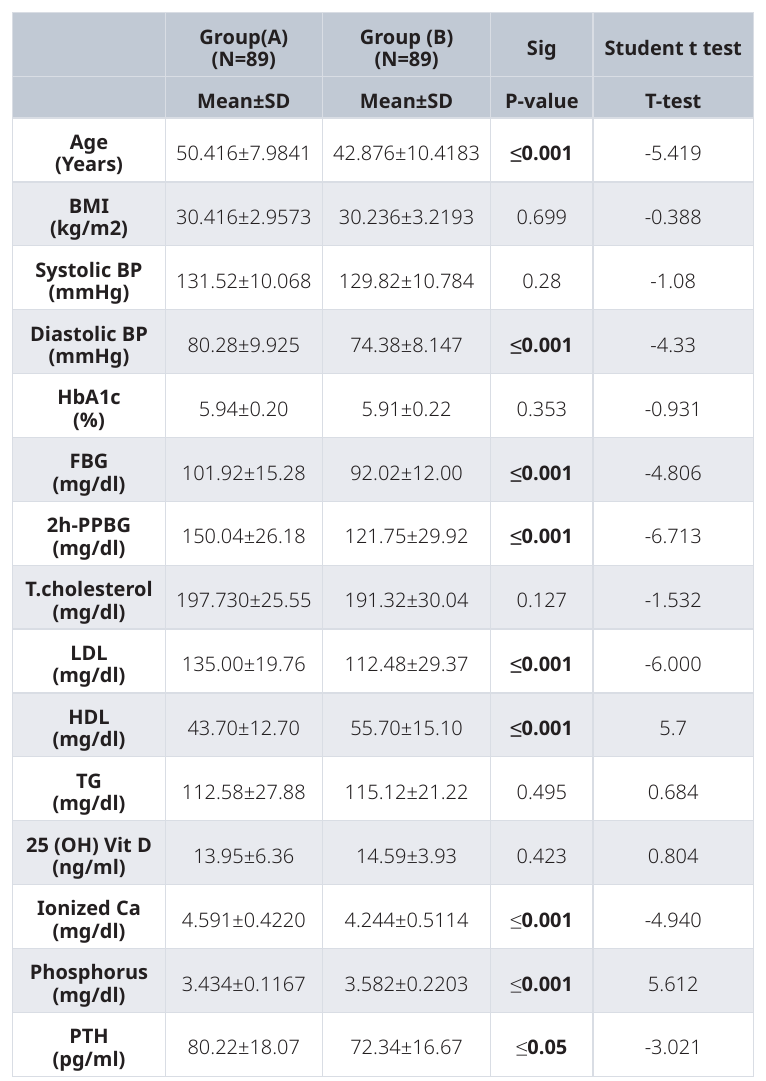
Table 1. Comparison between the two studied prediabetic patient with (Group A) and without (Group B) peripheral